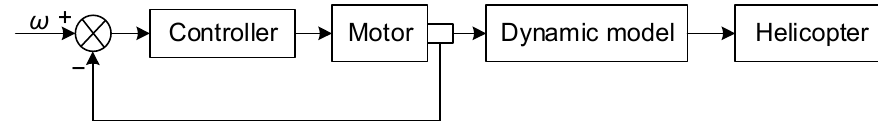
Figure 14. The power bond graph model of ETD.